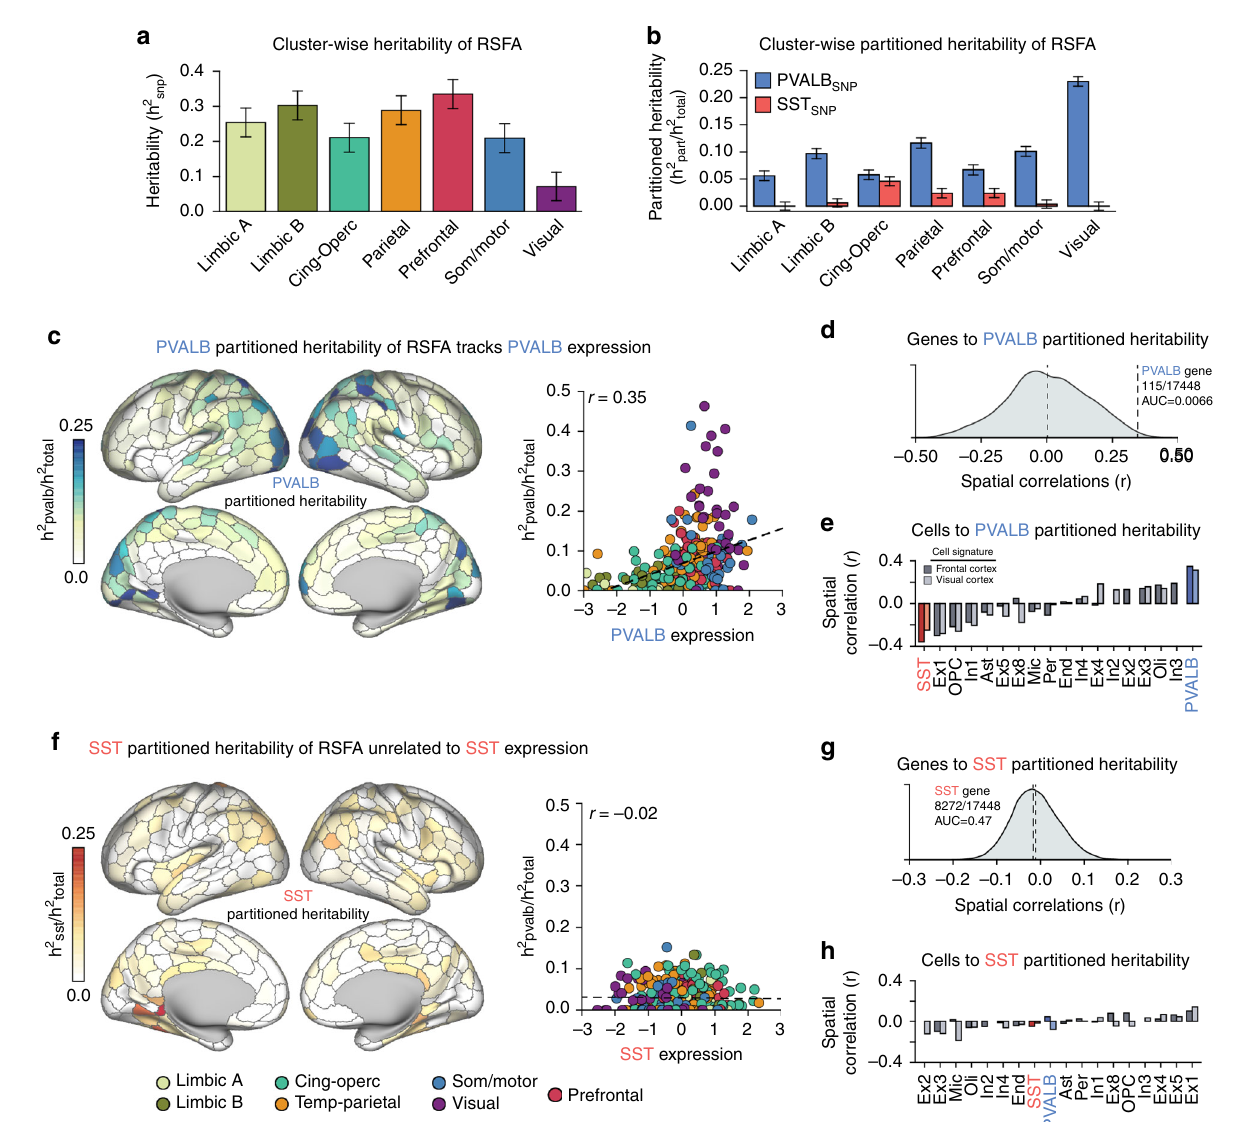
Fig. 5 PVALB -linked genetic variation explains patterns of heritable brain function. a RSFA was signi fi cantly heritable across the seven empirically de fi ned spatial clusters ( n = 9713 UKB subjects). b Partitioned heritability analyses reveal that the 500-gene PVALB SNP set accounted for a signi fi cant proportion of heritable variance in all seven clusters ( n = 9713 UKB subjects). c Parcel-wise PVALB SNP partitioned heritability of RSFA (left panel) tracks the = 0.40, p = 2.2e − 14). d Across all genes, PVALB was the 115th PVALB single-gene expression across cortex (Pearson ’ s r (326) = 0.35, p = 1.04e − 10; r s most correlated gene to PVALB SNP partitioned heritability (AUC = 0.007). e Across all deconvolved cell types, inferred PVALB cell fraction was the most positively correlated to PVALB SNP partitioned heritability (frontal cortex: Pearson ’ s r (329) = 0.35, p = 2.27e − 11; r s = 0.39, p = 2.20e − 13; visual cortex: Pearson ’ s r (329) = 0.31, p = 6.67e − 9; r s = 0.34, p = 1.50e − 10). f SST SNP partitioned heritability was not associated with SST single-marker expression (Pearson ’ s r (326) = − 0.02, p = 0.75), a null fi nding that was consistent when put in context of all genes ( g ) and inferred cell types ( h ). Error bars = standard